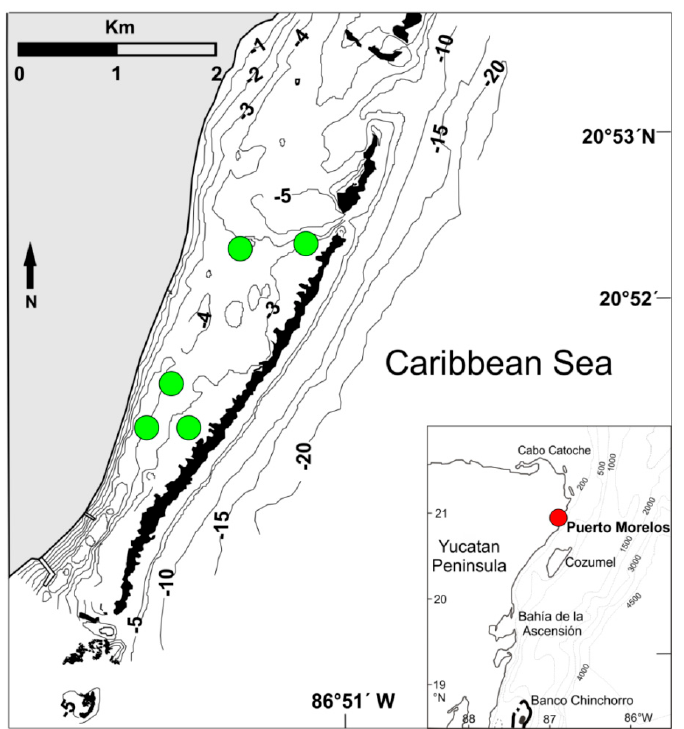
Figure 1. Location of the five sampling sites (green dots) in the Puerto Morelos reef lagoon, Mexico. The black areas denote the reef crest. Isobaths are in meters. Inset shows the location of Puerto Morelos on the Mexican Caribbean coast (red dot).